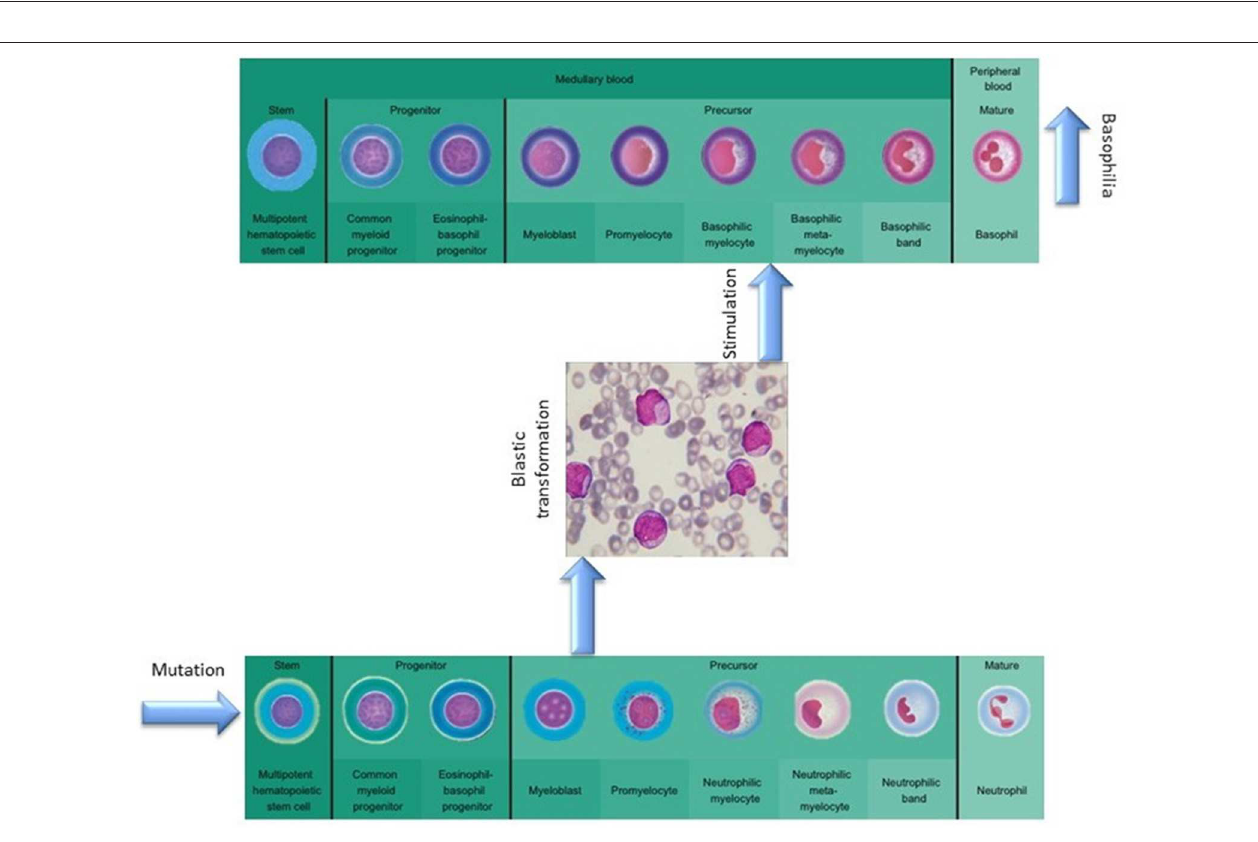
Frontiers in Oncology |